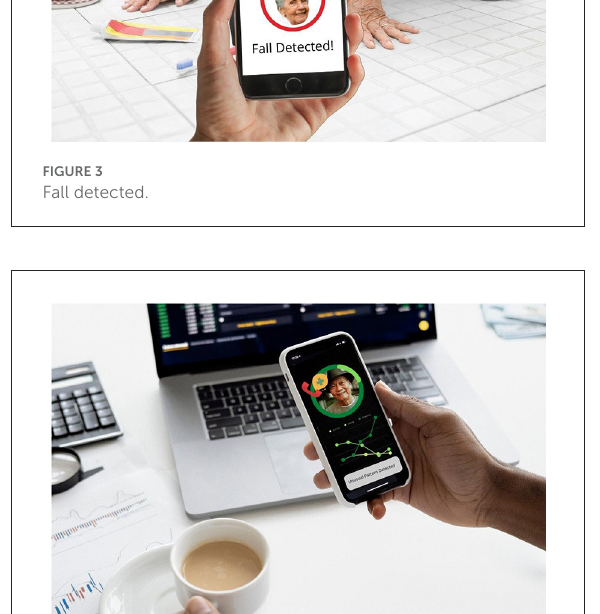
FIGURE4 Progress report.